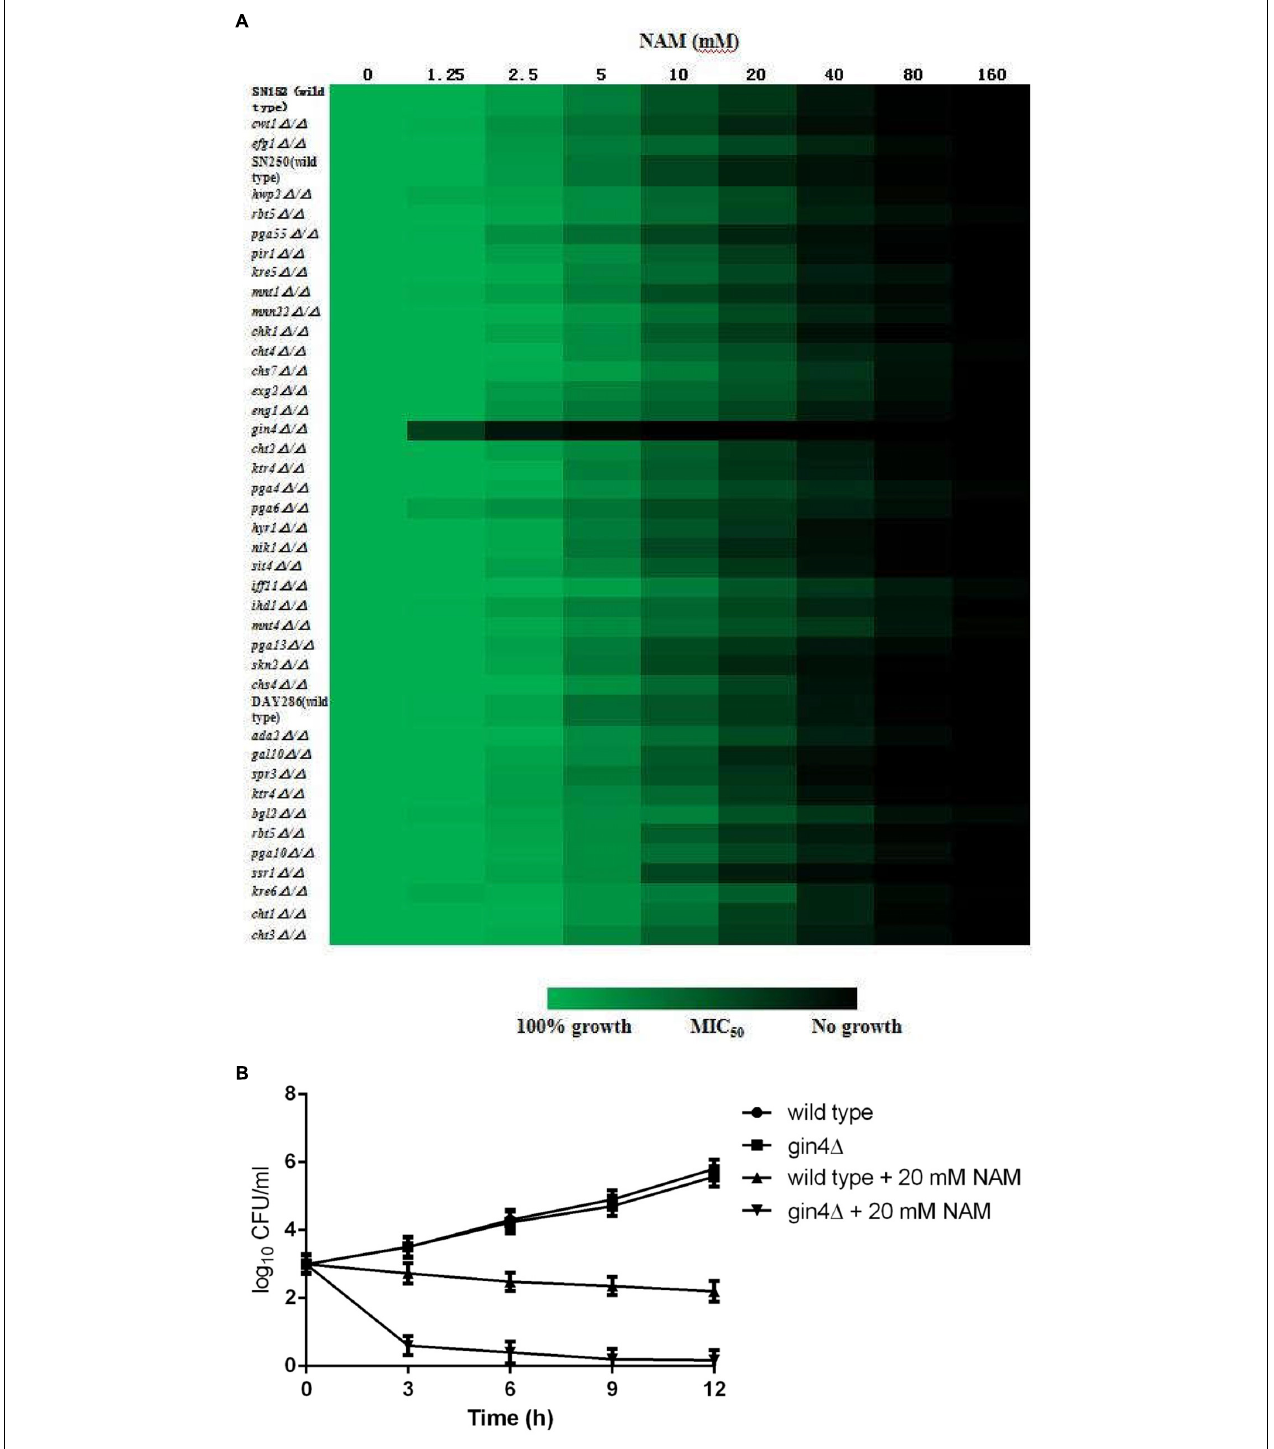
FIGURE 6 | (A) Sensitivity of C. albicans mutants to NAM. Antifungal susceptibility testing with NAM was performed using wild type and C. albicans mutant strains. Relative growth as monitored by OD 600 was normalized to the drug-free control for each strain and is displayed in heat map format. Data represent the mean of results from three independent experiments. (B) Time-kill curves of NAM against C. albicans gin4 ∆ / ∆ mutant and wild type strain SN250. 1 × 10 3 cells/ml of C. albicans cells suspended in RPMI 1640 medium were treated with 20 mM of NAM and then incubated with agitation at 30 ◦ C. At each designated time points, portions of cell suspensions were withdrawn and plated on YPD agar to determine the CFU/ml of the cell suspensions. The data shown are means ± standard deviations from three independent experiments.